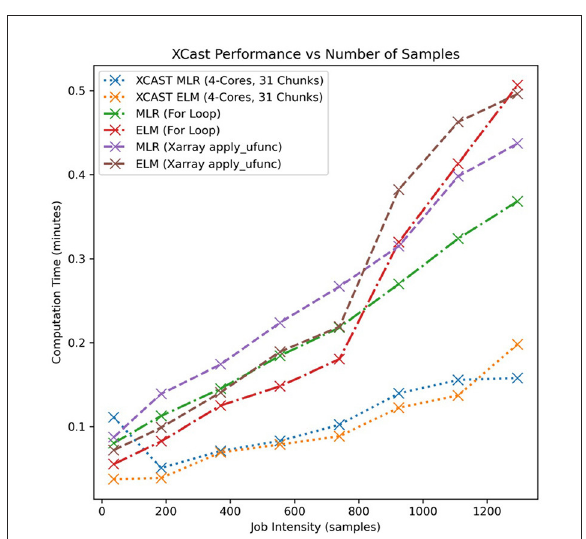
FIGURE4 Comparison of training time for a 31-chunked, 4-core configuration of XCast with that of Xarray and For-Loop-based implementations. Number of training samples at each point is used as an analog for job intensity, and two different statistical methods are